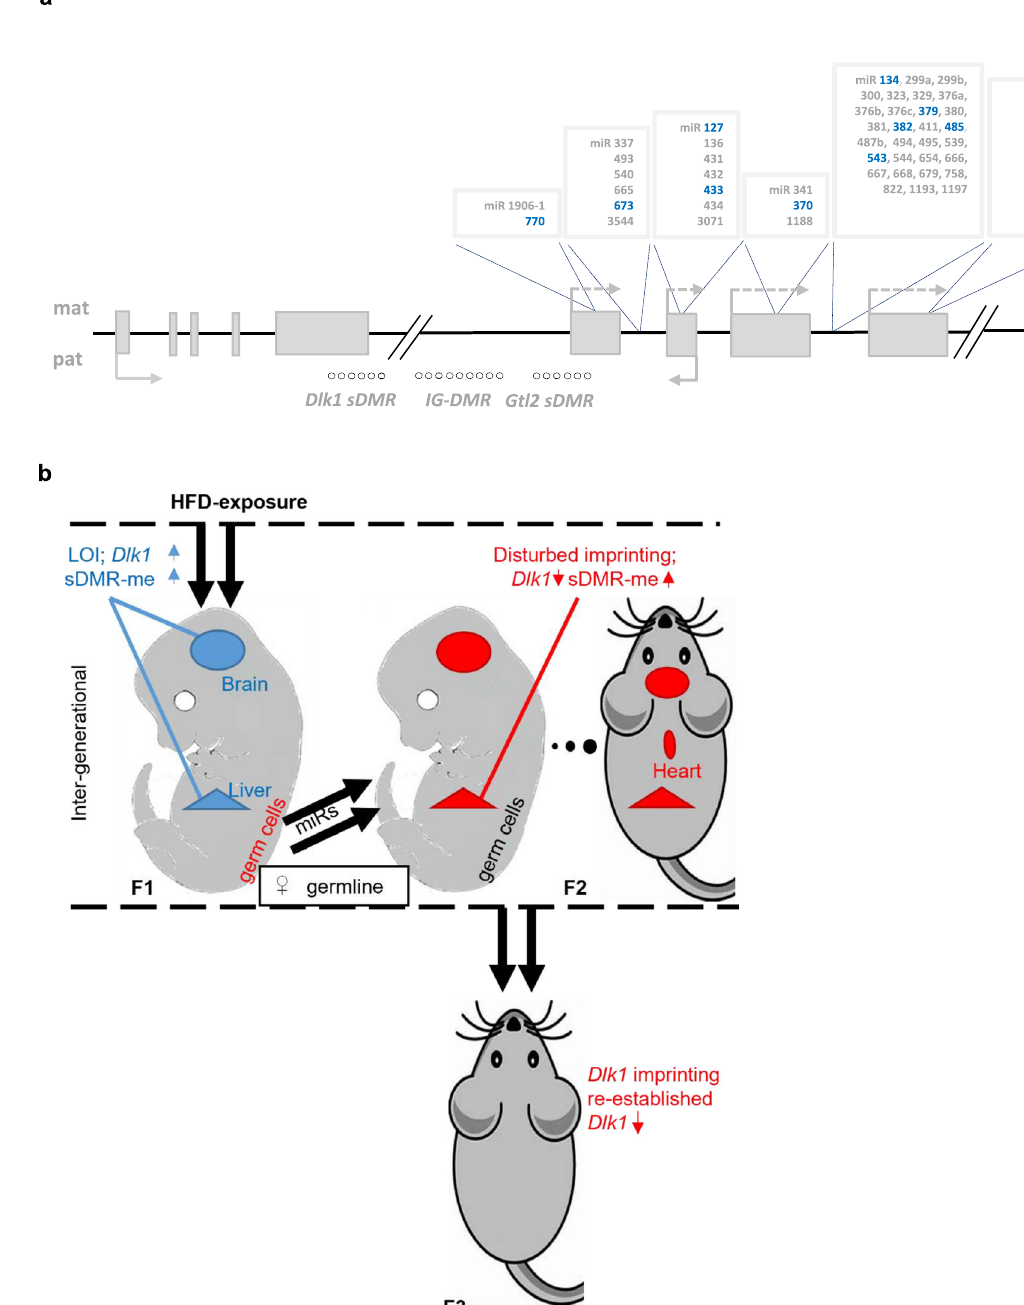
Fig. 7 Generational modulation of Dlk1-Dio3 imprinting in response to HFD exposure. a Schematic of Dlk1-Dio3 cluster miRs that were over-expressed in F1 mat-HFD oocytes, as compared to F1 mat-CD . Over-represented miRs are displayed as blue, while non-expressed miRs are displayed as grey. b Schematic summarizing the modi fi cations to Dlk1 imprinting across generations. Imprinting is disturbed inter-generationally but restored trans-generationally. Blue (increased) and red (decreased) arrows depict expression or methylation levels relative to embedded in OCT (Fisher Scienti fi c) and stored at − 80 °C. Embedded tissues were sectioned (12 µm) with a CM1950 cryostat (Leica). Sections were blocked with 10% normal goat serum (Thermo Scienti fi c) in PBS, 0.1% Tween20 at RT for 1 h. combined to form an integrated absorption coef fi cient image at each projection Following blocking, samples were incubated with primary antibodies (antibody angle. 3D reconstructions of the absorption coef fi cient per voxel were produced using a fi ltered back-projection algorithm 75 . The whole sample volume was reconstructed from fl uorescence OPT imaging with 473nm excitation (Cobolt BluesTM, Cobolt AB) and acquisition at 520± 17 nm (FF01520/35-25, Laser 2000 UK Ltd). Immunostaining . The tissue was dissected and fi xed in ice-cold 4% PFA in PBS O/ N with gentle rocking. The tissue was washed in PBS the following morning,